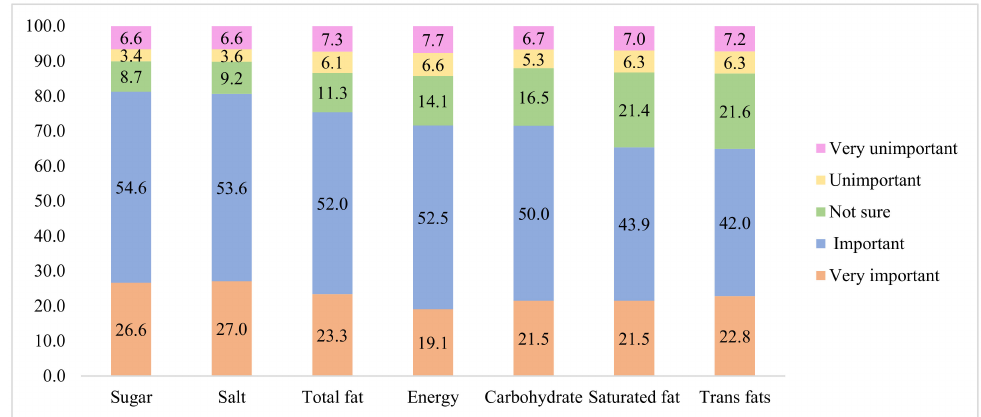
Figure 2. The nutrients preferred to be identified on FOPL